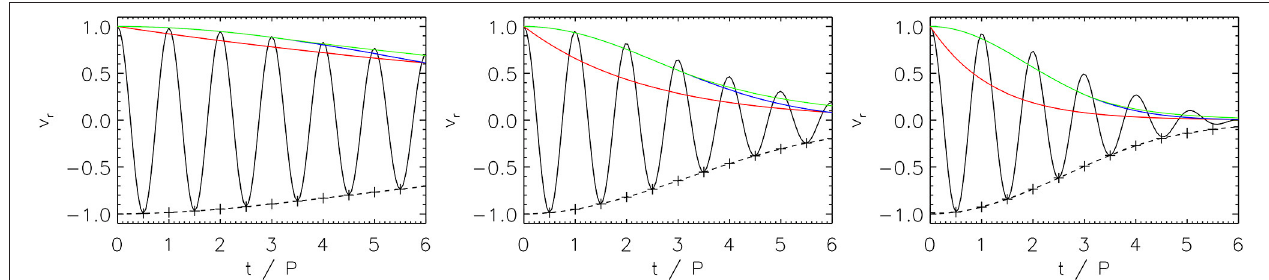
FIGURE 1 | Comparison of kink oscillations calculated by numerical simulations (solid lines) with the analytical damping profiles (colored lines). The red, blue, and green lines correspond to the exponential, Gaussian, and general damping profiles, respectively. The plus symbols represent the amplitudes used to characterize the oscillation in our lookup table (LUT). The LUT damping profiles (dashed lines) are constructed from these amplitudes by spline interpolation. The left , middle , and right panels show the results for ǫ = 0.1, 0.5, and 1.0, with ζ = 2 for all